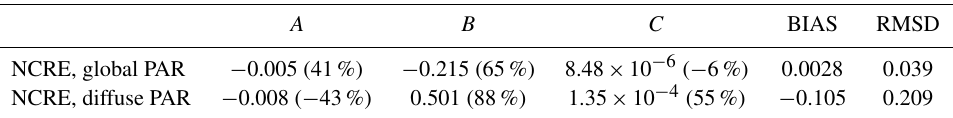
Figure 11. Time series of monthly normalized cloud radiative effects for global (black) and diffuse (green) PAR, and cloud top pressure ( a , red dashed line), cloud fraction ( b , red dashed line) and cloud optical thickness ( c , red dashed line). Cloud properties are derived from MODIS Aqua observations. Table 5. Coefficients of the multilinear regression and statistics between NCRE and clouds properties (cloud optical thickness, cloud fraction, and cloud top height). Percentages in brackets represent the contribution of each term of the multilinear regression to the NCRE